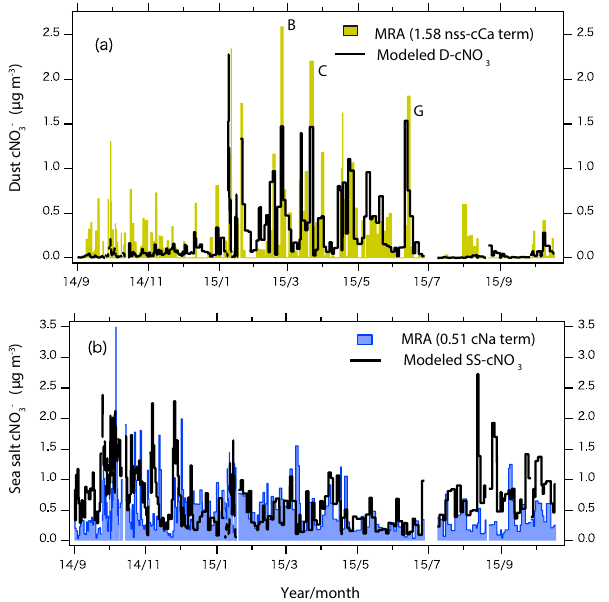
Figure 7. (a) D-cNO − estimated by multiple regression analysis 3 and modeled D-cNO − ; (b) the same parameters for sea salt NO − 3 Modeled results averaged over the same time period as for the D-F measurements.